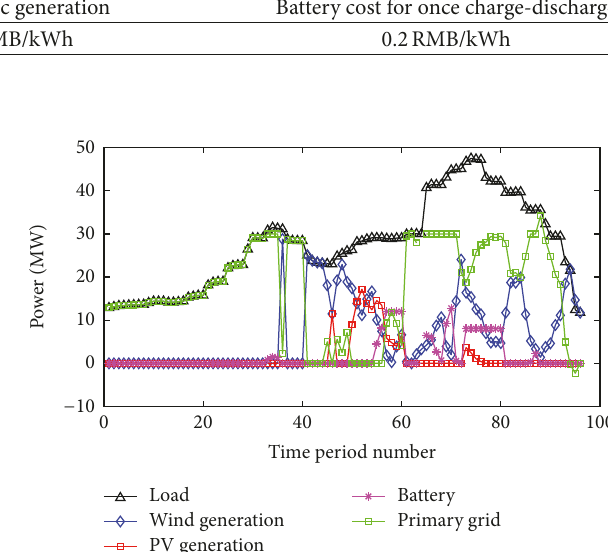
Figure 7: Power dispatching in normal